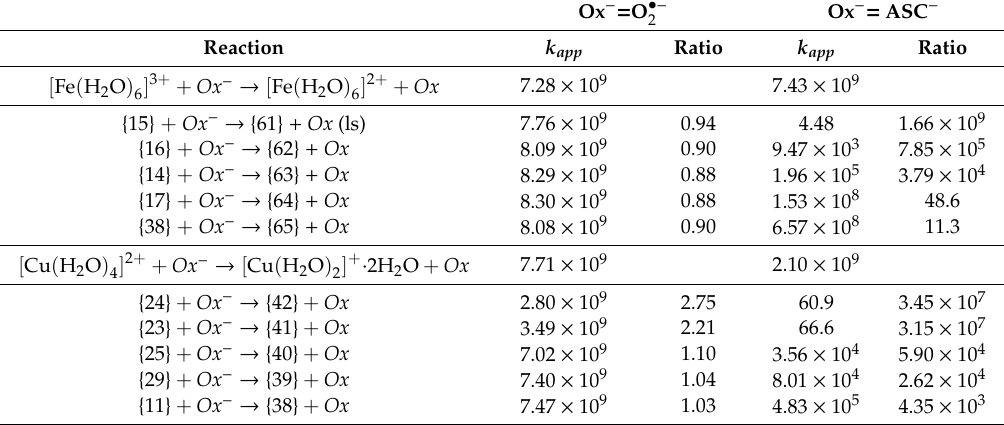
Table 2. Rate constants (in M − 1 s − 1 ) for the reduction of Fe(III) and Cu(II) complexes (with and without complexation with AG) with O constant ratios (using the reduction of [ Fe ( H 2 O )